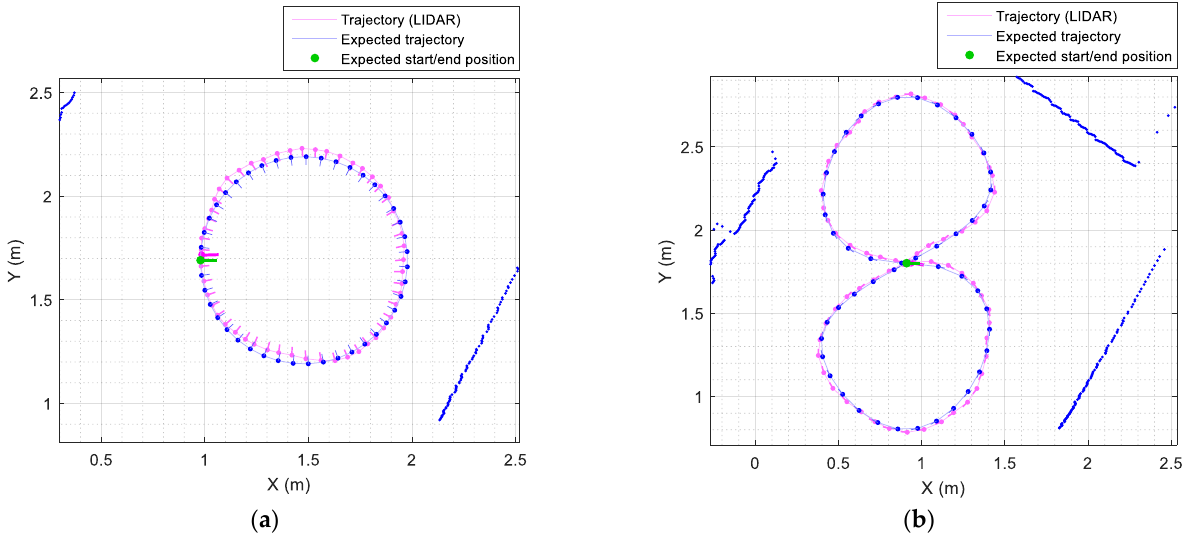
Figure 7. Comparison between the planned (blue line) and real (magenta) trajectories of the mobile robot moving at a constant speed of 0.15 m/s. The green line depicts the expected initial and final positions and orientations of the mobile robot: ( a ) describing a circular trajectory with the robot facing inward and ( b ) describing an eight-shaped trajectory with the robot facing forward.